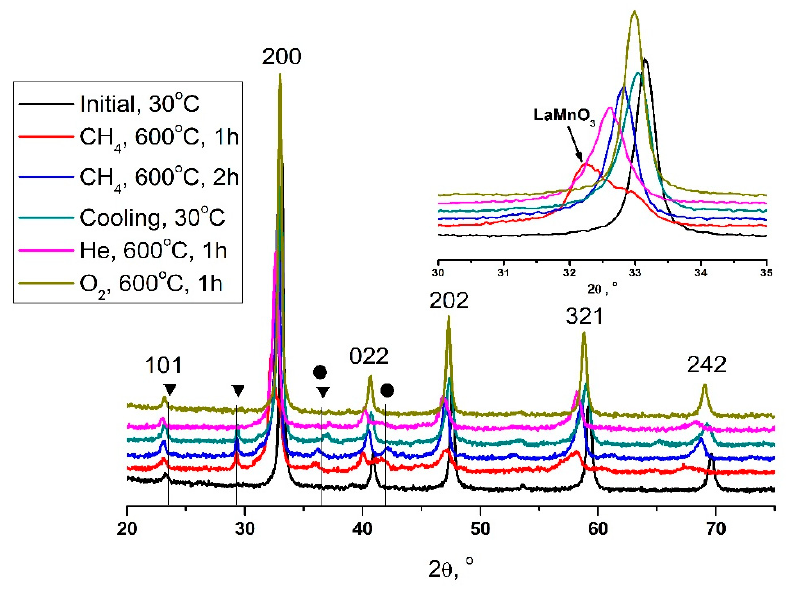
Figure 2. XRD pattern of La 0.5 Ca 0.5 Mn 0.5 Co 0.5 O 3 obtained under the reaction conditions. The triangles indicate the calcite phase and the cobalt oxide phase is indicated by the circles.